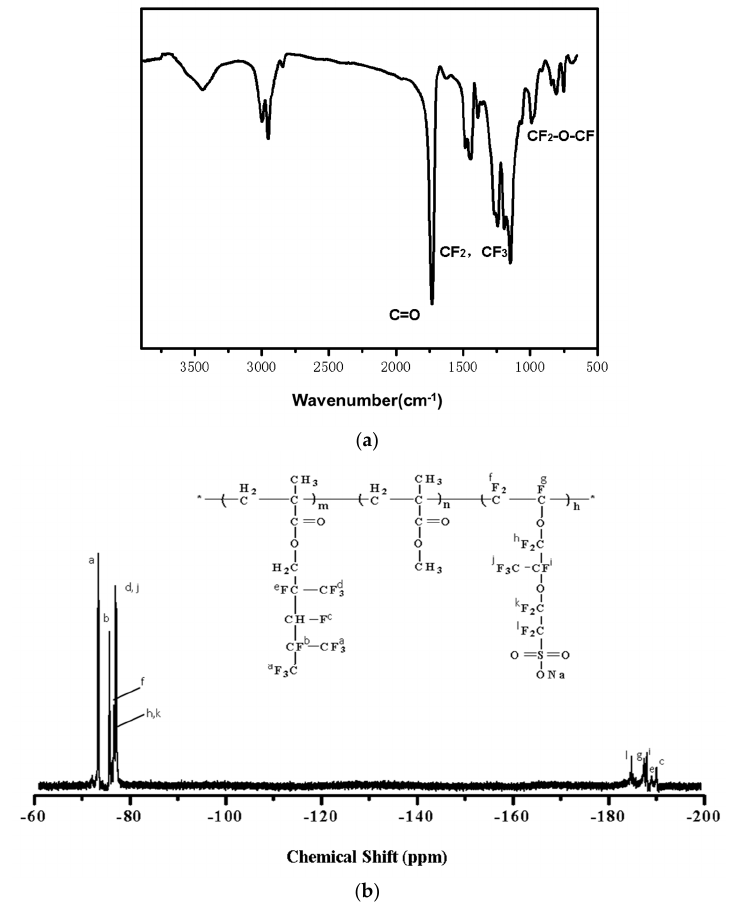
Figure 8. FTIR Spectra and 19 F NMR spectrum of latex films.